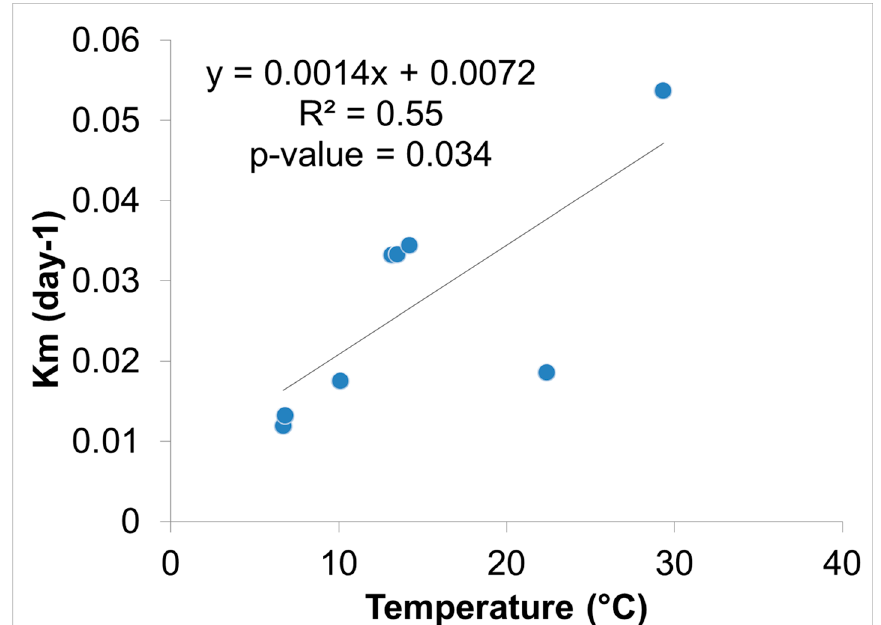
Figure 8. Hg methylation rate vs. ambient water temperature near the sediment surface ( n = 8).